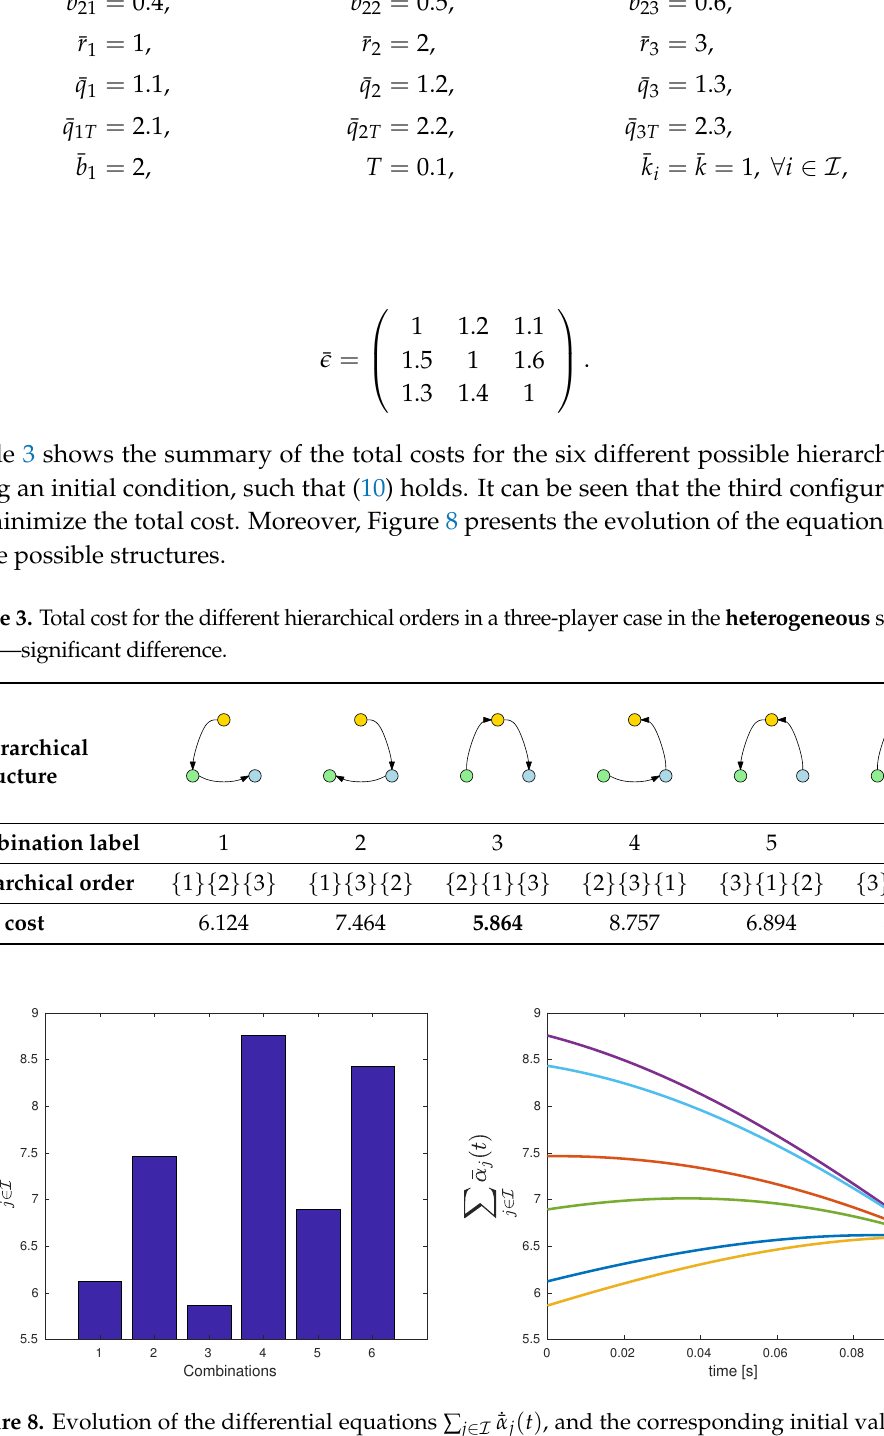
Figure 8. Evolution of the differential equations ∑ j ∈I ˙¯ α j ( t ) , and the corresponding initial values for different hierarchical structures in the heterogeneous